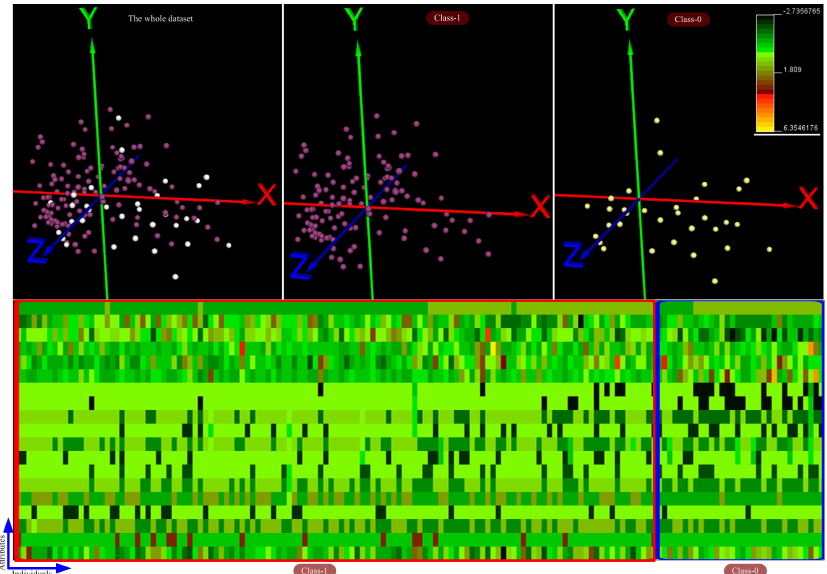
Figure 2. DS2 dataset (Hepatitis Dataset). A 3D-scatterplot is shown at the top of the figure where each point represents a a column (an individual) of the dataset showed as a heatmap at the bottom. The dimension of the dataset was reduced to three components by using principal component analysis. In addition, points belonging to each class are shown in different colors. The heatmap corresponding to the same dataset is shown at the bottom of the figure. Each class of the dataset is framed in a box. The color bar shown at the top represents the color scale used in the